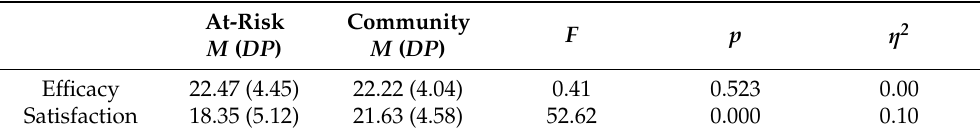
Table 6. Comparisons of efficacy and satisfaction scores between at-risk (N = 273) and community (N = 205) sample.